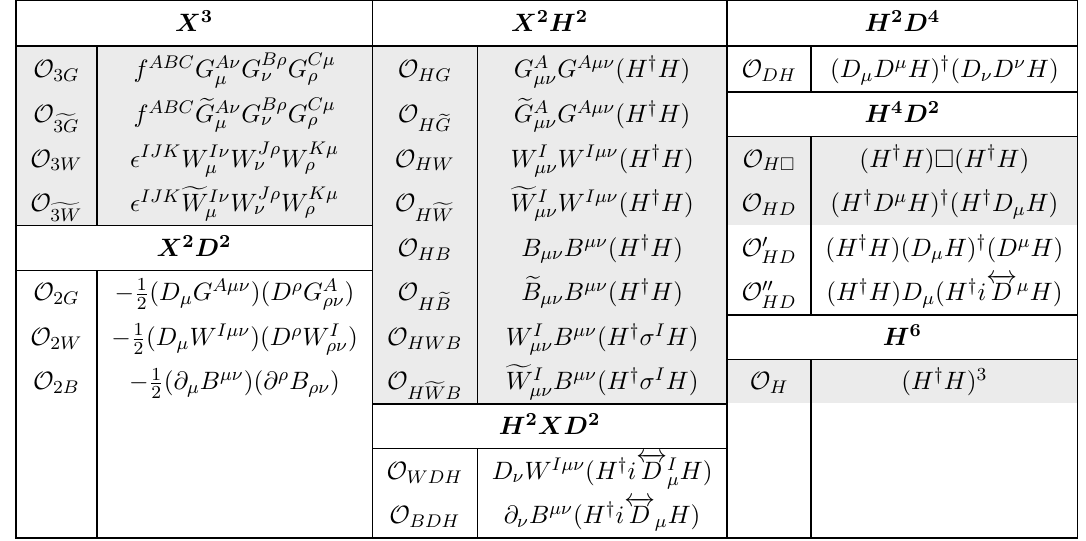
Table 1 . Bosonic operators in the Green’s basis. Shaded ones are also included in Warsaw